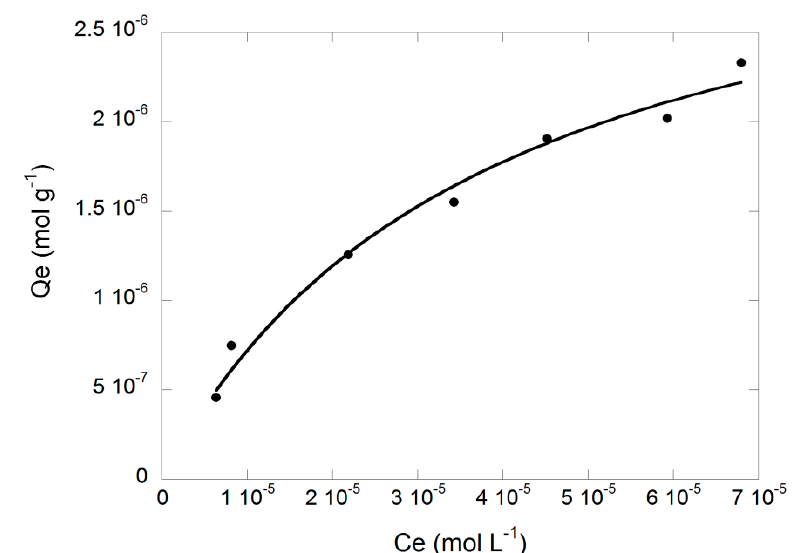
Figure 8. Adsorption isotherm of methyl orange (MO) on the hybrid material in HCl 0.1 N (results correspond to the mean ± standard error mean of three independent assays).